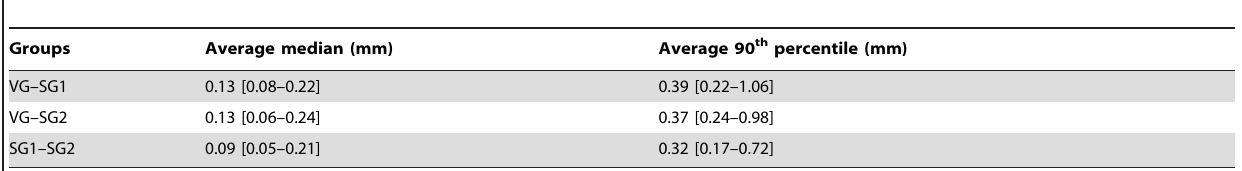
Table 2. Median, 90 th percentile and range of surface errors of 3D rendered condyles between the three groups (distance map).